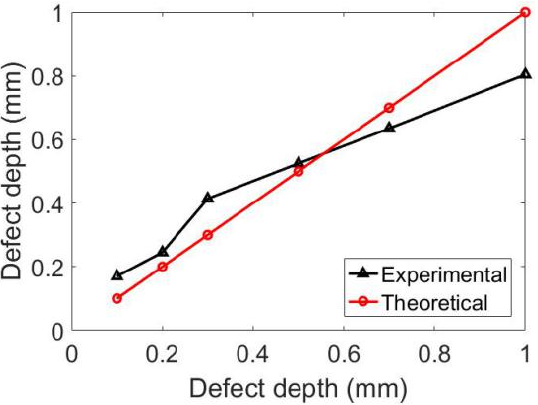
Figure 9. Comparison chart of the experimental and theoretical value of the effect depth.